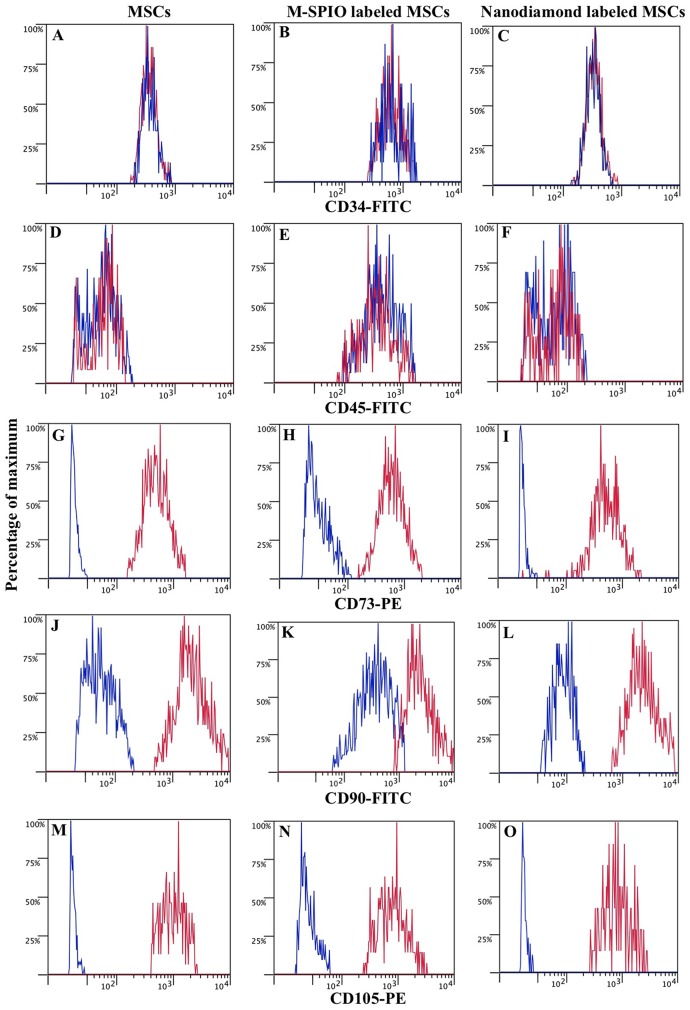
CD marker characterization of control and labeled adipose-derived mesenchymal stem cells.MSCs were cultured alone or in the presence of superparamagnetic iron oxide particles (M-SPIO) or nanodiamonds for 3 days. Control MSCs (A, D, G, J, M), MSCs labeled with M-SPIO particles (B, E, H, K, N) and MSCs labeled with nanodiamonds (C, F, I, L, O) were subsequently analyzed for their CD marker expression profiles. A comparison of unstained (blue) and stained cells (red) illustrated that control and labeled MSCs were negative for the hematopoietic markers CD34-FITC (A–C) and CD45-FITC (D–F) and positive for the stromal markers CD73-PE (G–I), CD90-FITC (J–L) and CD105-PE (M–O).